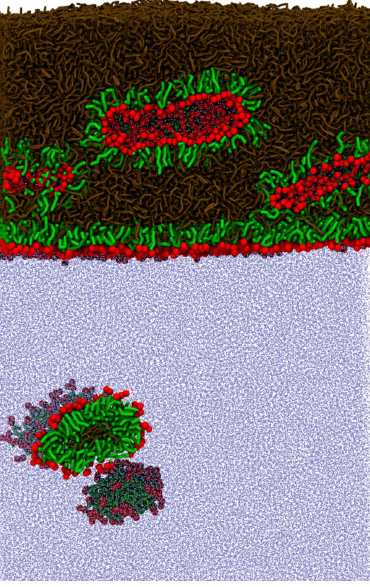
Figure 10. Simulation snapshot of the extended, laterally compressed system. The snapshot is taken at about 400 ns of the non-equilibrium compression trajectory of the sixteen-fold extended system. Inversed micelles are present in the non-polar lipid phase (both attached to and detached from the polar lipid layer. A micelle is present in the water phase. For color coding, see Fig.2A. Note that the picture represents a single simulation box, i.e., no lateral periodicity was applied. The lateral size of the box is of about 43 nm.